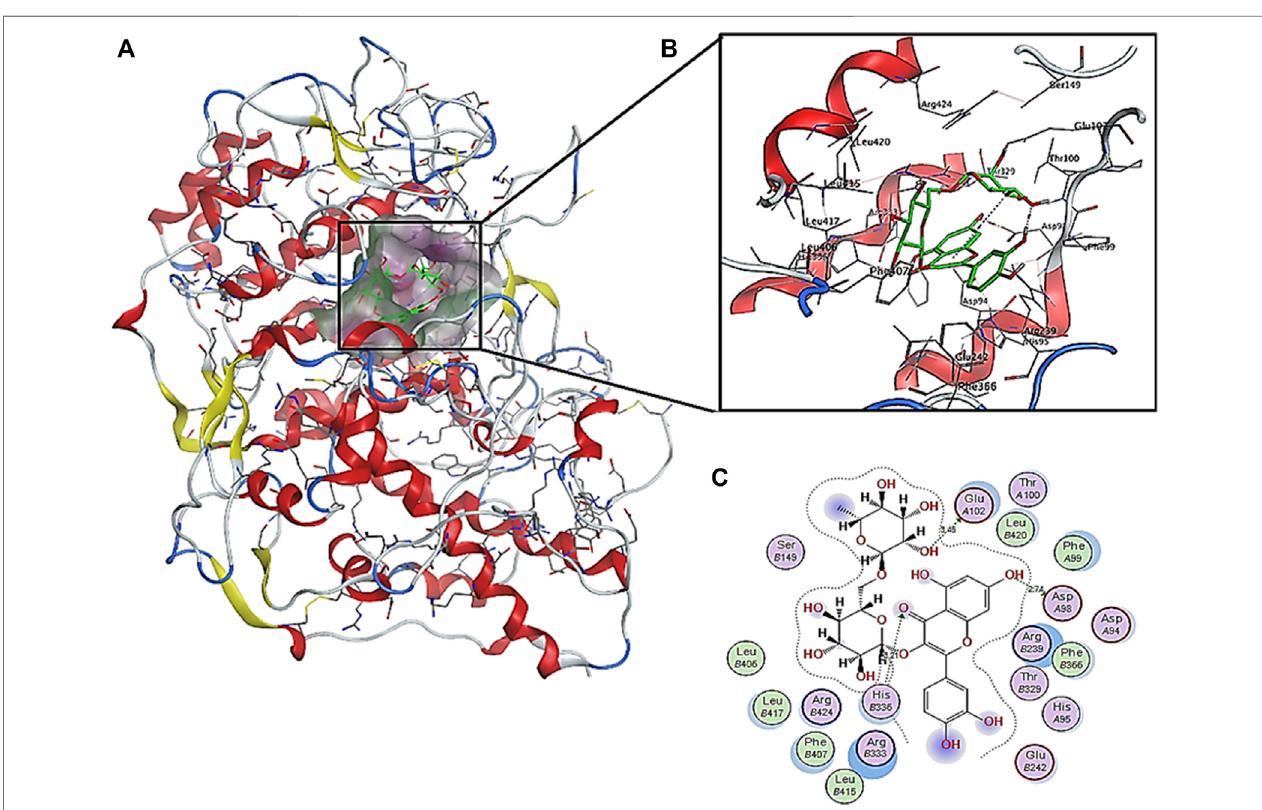
FIGURE 5 | Predicted binding pose interactions with the residues of myeloperoxidase antioxidant target proteins: (A) whole protein binding site; (B) 3D interaction model; (C) 2D interaction model.